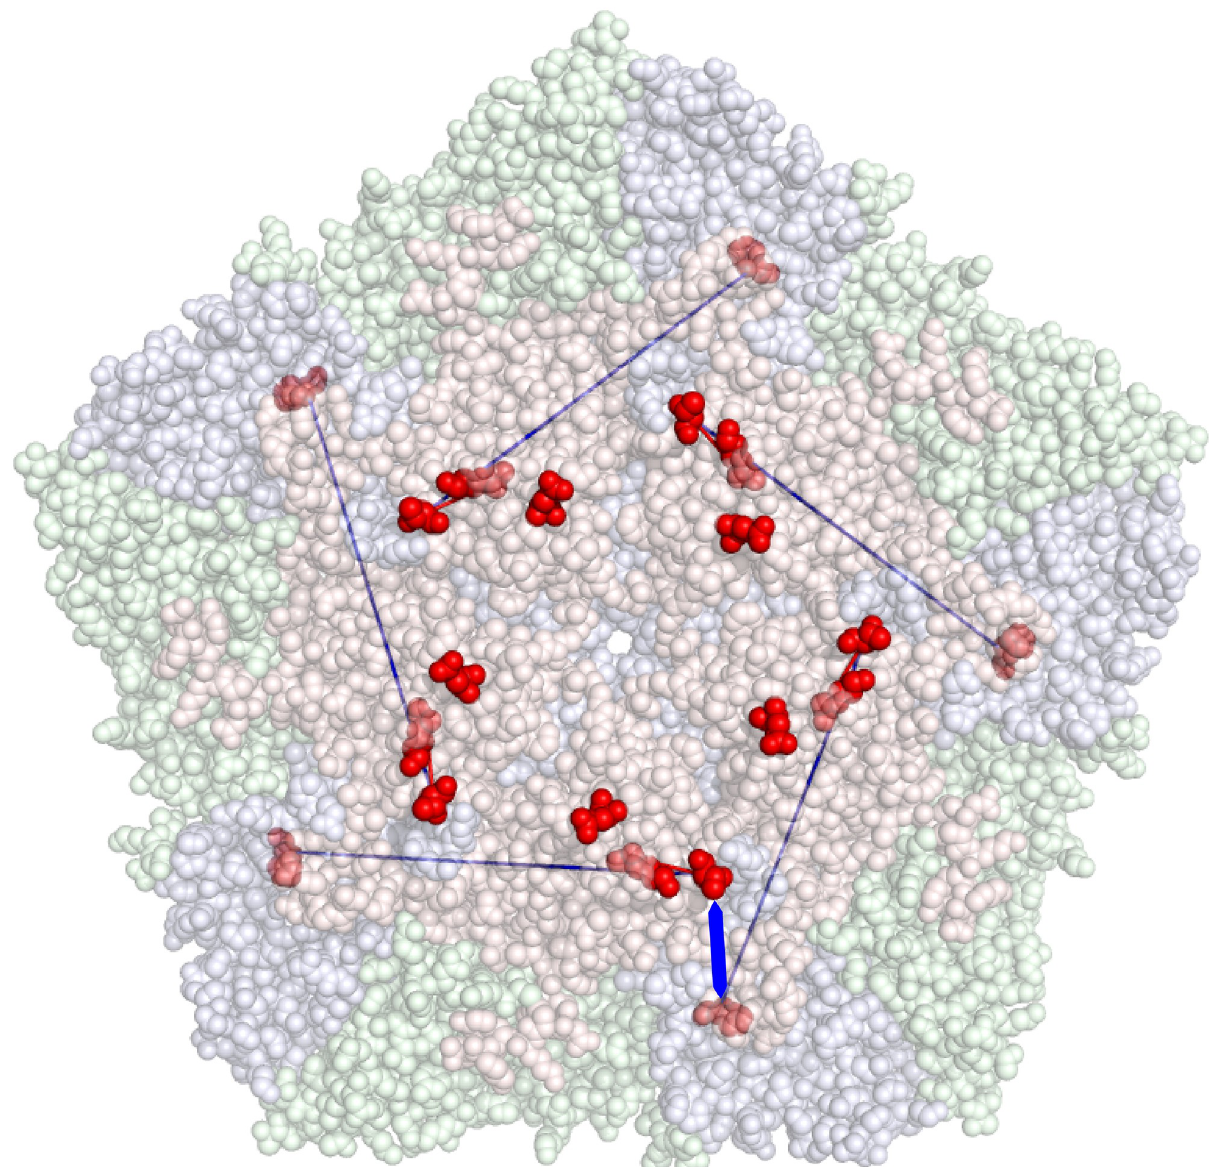
Fig 8. Localisation of the aminoacids corresponding to the four subpopulation-specific non-synonymous variants involved in epistatic interactions, projected on the capsid structure of SAT1. The red, green and blue components of the capsid correspond to VP1, VP2 and VP3 respectively. Exposed aminoacids corresponding to the variants are shown in dark red. Two epistatic interactions are illustrated, a strong one between H18Y and A99T (in blue) and a weaker one between K49R and A99T (in red). Note that the first interaction could also occur between residues H18Y and A99T from two different VP1 proteins (thick blue arrow), which are physically much closer in the capsid